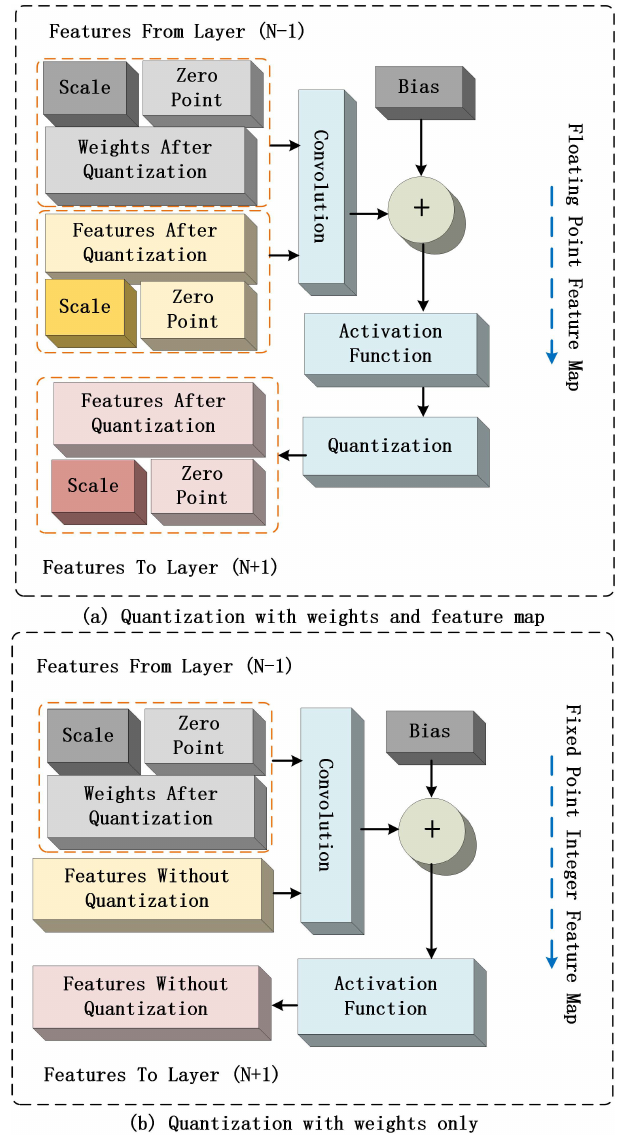
Figure 4. Schematic illustration of ( a ) full quantization (i.e., quantization of both weights and features) and ( b ) partial quantization (i.e., quantization of weights only) of convolutional neural